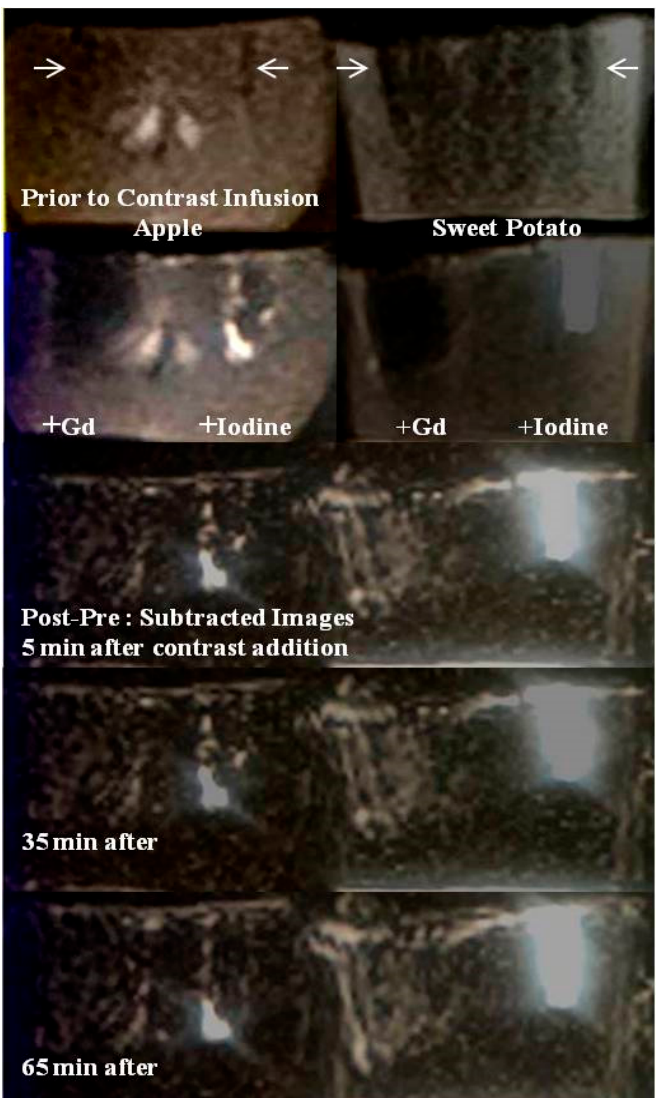
Figure 3. MR images of the mineral-rich model fruits and vegetables. First row: Pre-contrast MR image at 1.5T Siemens system, apple (left) and sweet potato (right). Manually carved wells (2 × 2 × 10 mm 3 or 0.04 mL volume) are shown (white arrows). Second row: Post-contrast MR image when Gadavist is added at the left wells and Iohexol in the right wells for both fruits. Notice signal loss due to paramagnetic nature of Gd 3+ and enhanced signal due to Iohexol. Third to fifth rows: Time series subtraction images (post-pre contrast) at time = 5 min, 35 min and 65 min are shown. More pronounced enhancement is seen with Iohexol in sweet potato.